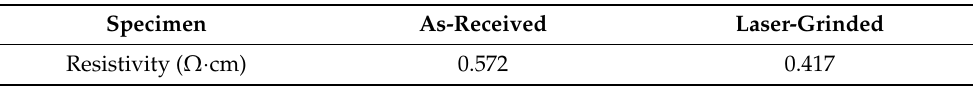
Table 1. The resistivity of single-crystal silicon wafer samples with as-received and laser-grinded.